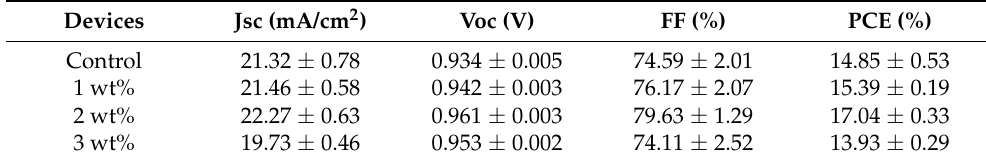
Figure 6. Distribution of the ( a ) J SC , ( b ) V OC , ( c ) FF, and ( d ) PCE of the devices based on perovskite films with different CsPbI3 QDs concentrations. Table 1. Photovoltaic parameters of PSCs.